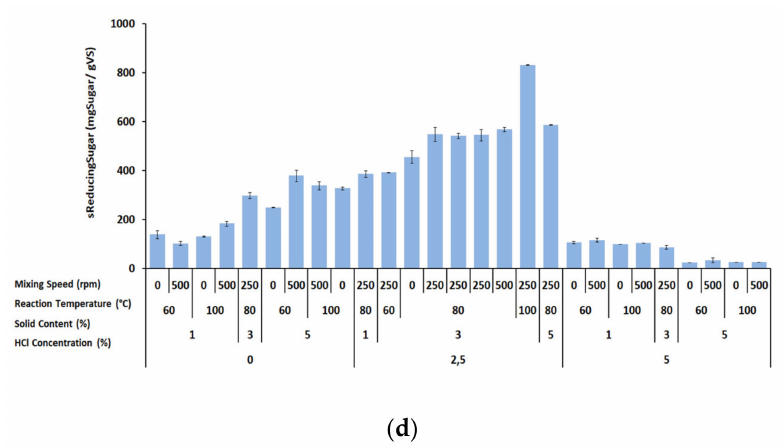
Figure 1. E ff ects of NaOH-assisted thermal pretreatment on sCOD ( a ) and sRedSugars ( b ); and e ff ects of HCl-assisted thermal pretreatment on sCOD ( c ) and sRedSugars ( d